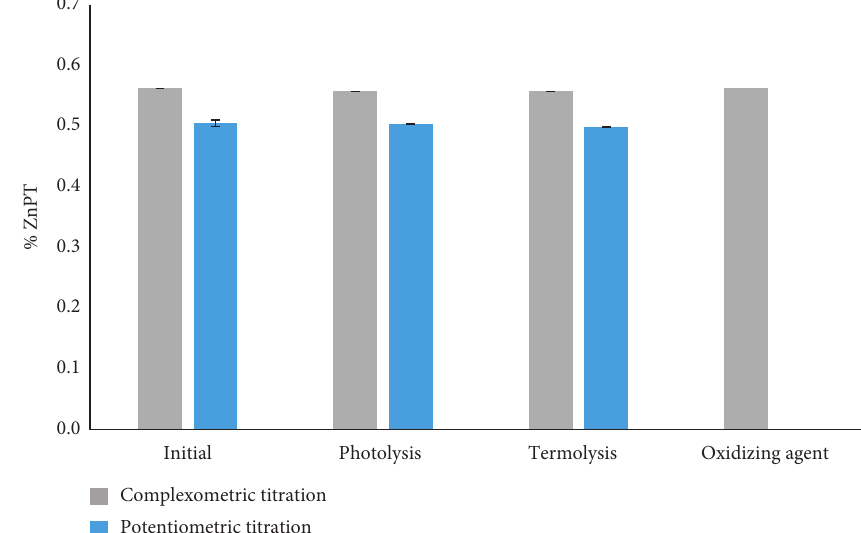
Figure 1: Selectivity of the method under stress conditions. The error bars represent the standard deviation of the replicates made for each working condition ( n �